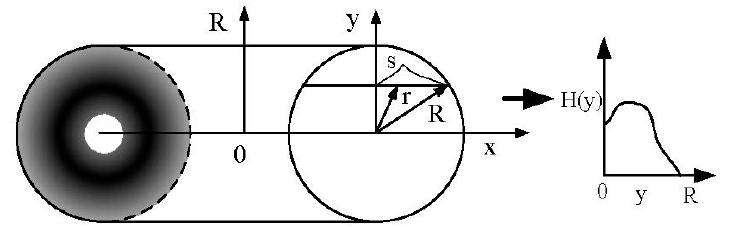
Figure 3. Thickness profile of the circular deposition model, formed by the translational circular deposition model.